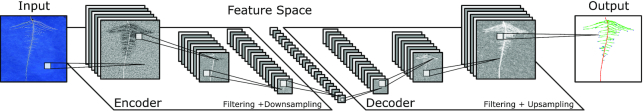
A simplified example illustrating the major components of a CNN in an encoder-decoder configuration. The encoder performs a combination of filtering operations including convolutional filters, spatial downsampling, and normalization. These layers convert the original image into a high-dimensional feature space but with very low spatial resolution. The decoding network performs similar layer operations but replaces downsampling with upsampling to return the feature representation back into a spatially high-resolution image.